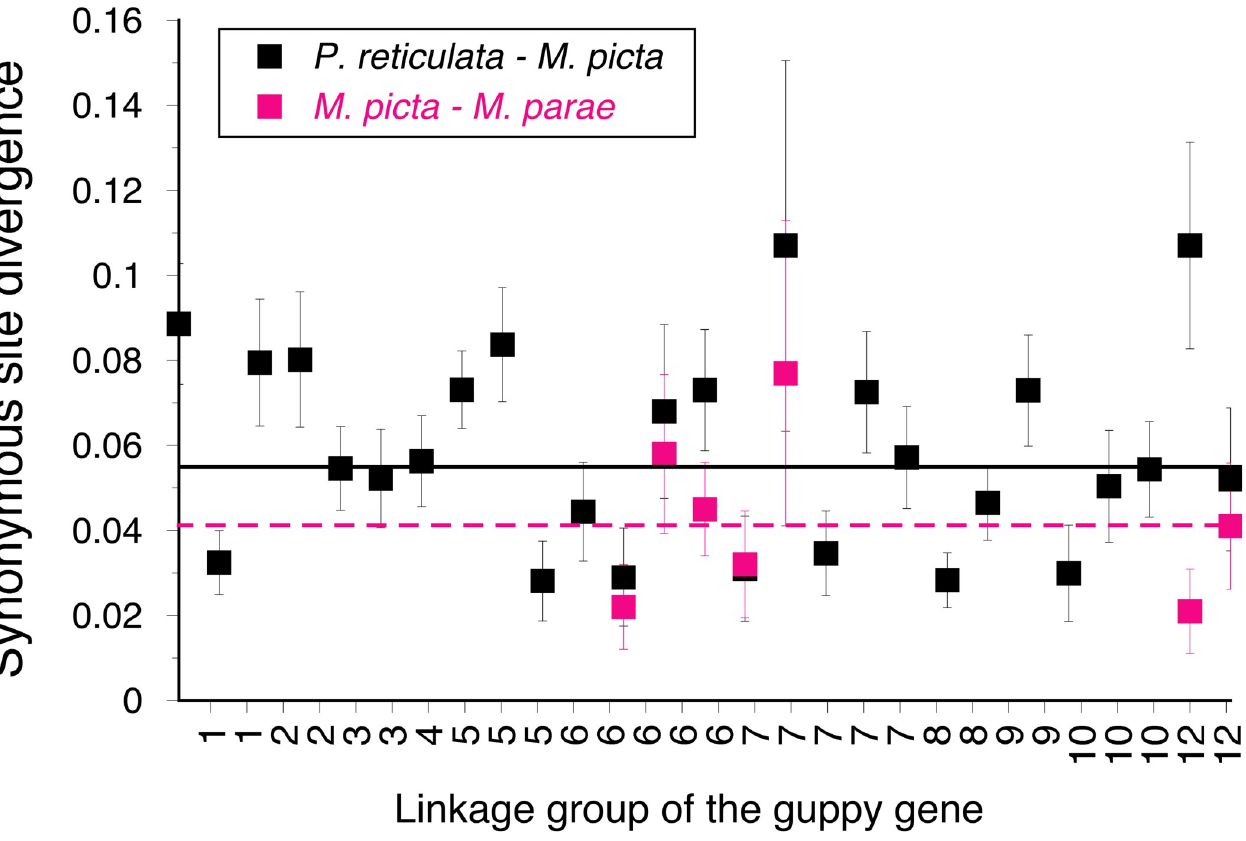
Fig 3. DNA sequence divergence between the guppy and M . picta and between two Micropoecilia species. Divergence estimates are for synonymous sites in coding regions of 27 genes, with Jukes-Cantor correction for saturation of substitution, and 95% confidence intervals of the estimates. The horizontal lines indicate the median values (5.4% for P . reticulata versus M . picta , and 4.1% for M . picta versus M . parae . Divergence estimates between all three Micropoecilia species are given in S3B Table.